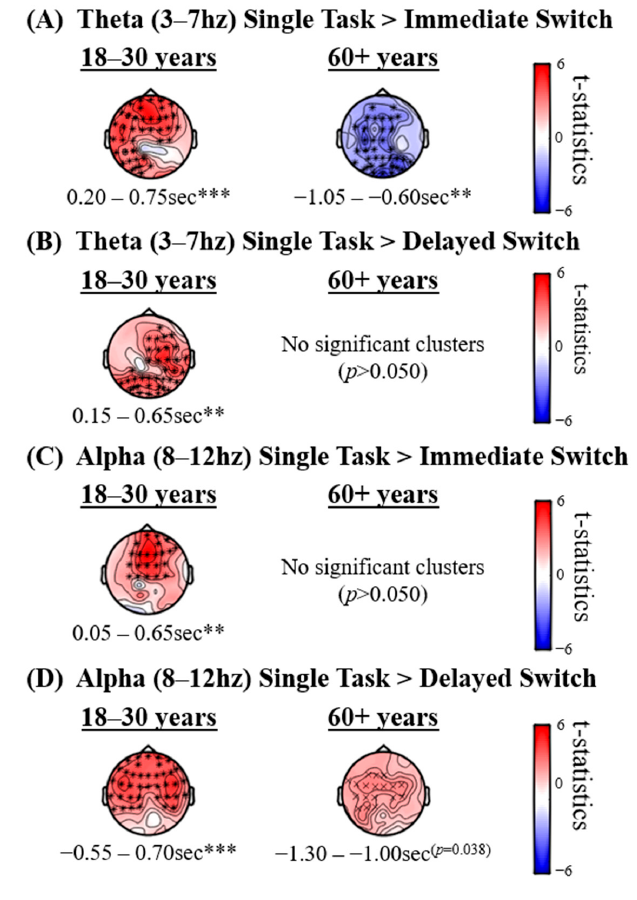
Figure 4. Effects in theta (3–7 Hz) and alpha (8–12 Hz) EEG power when contrasting Immediate Figure 4. E ff ects in theta (3–7 Hz) and alpha (8–12 Hz) EEG power when contrasting Immediate